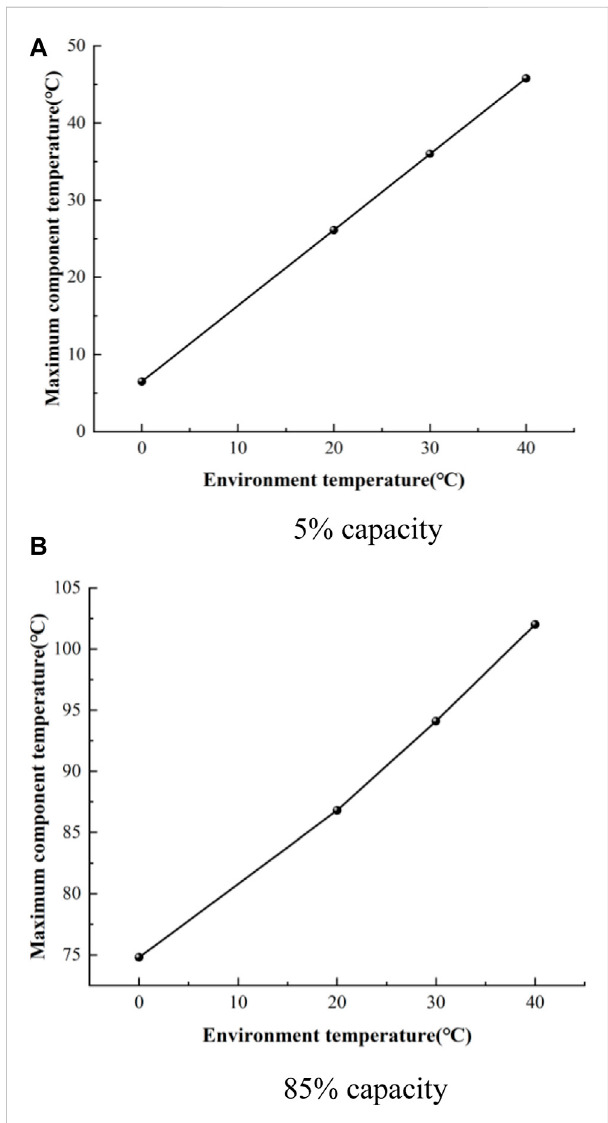
FIGURE 7 Relationship between transformer structure temperature and environment temperature under different